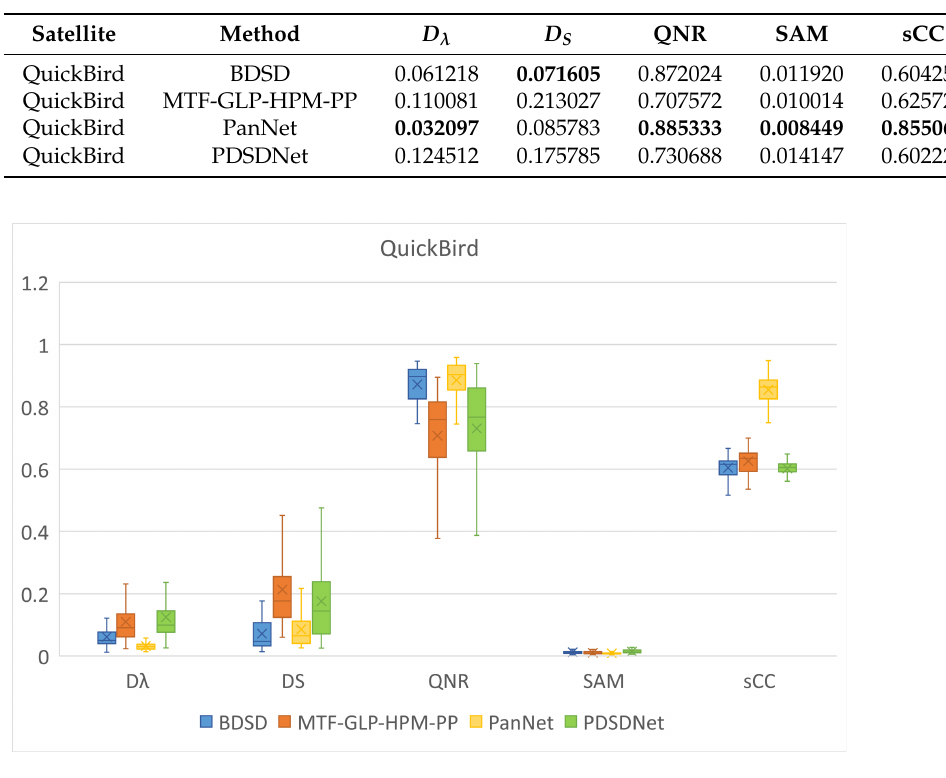
Figure 9. Quality indexes of results of BDSD, MTF-GLP-HPM-PP, PanNet, and